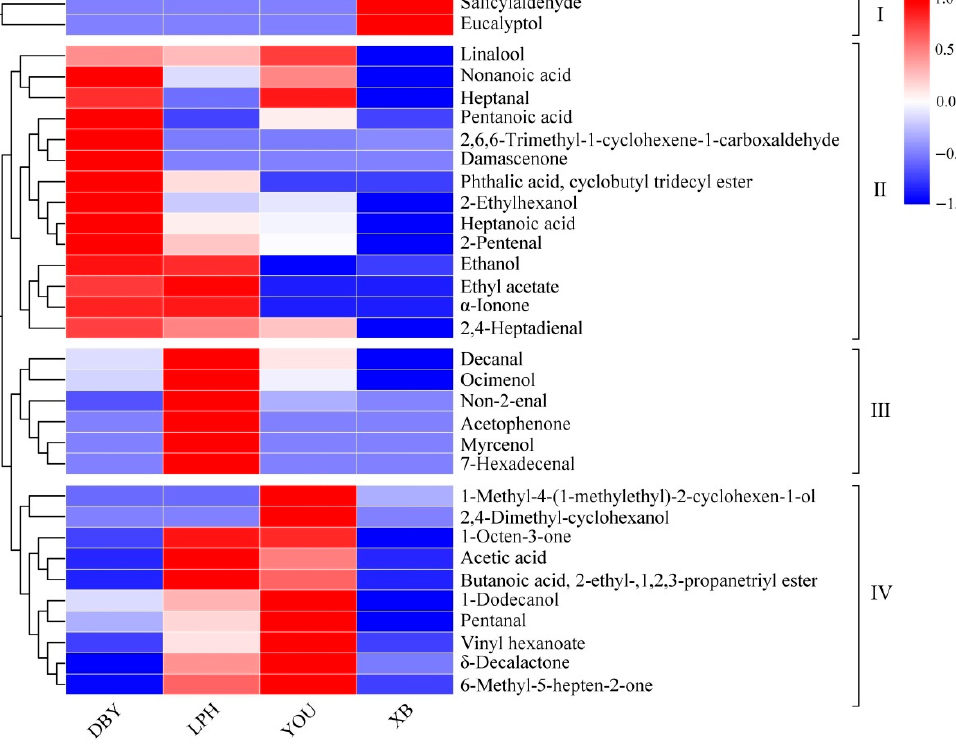
Figure 5. The heatmap analysis of the volatile compounds (VIP > 1) in four different apricot cultivars. DBY, Dabaiyou apricot; LPH, Luopuhongdaike apricot; YOU, You apricot; XB, Xiaobai apricot. Table 4. The biomarkers for the four different apricot cultivars. The seven differentiated volatile compounds whose VIP > 1.0 are shown in Table 4. Apricot Cultivars No Volatile Compounds RI